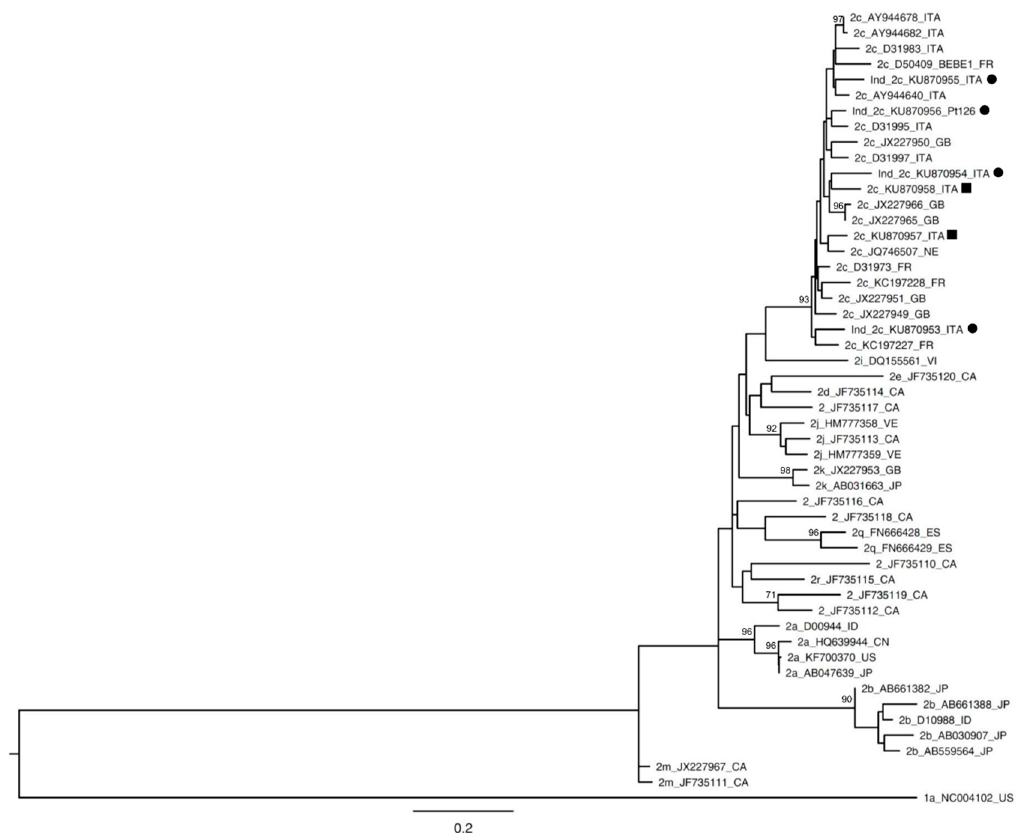
Figure 1. NS5B phylogenetic tree of genotype 2c samples. Bootstrap analysis with 500 replicates is performed to assess the significance of the nodes; values greater than 70% are considered significant and reported in the figure. A genotype 1a sequence (1a_NC004102_US) is used as the outgroup. Sequences from patients with an indeterminate result by Abbott RealTime HCV Genotype II assay are indicated with a circle ( ● ). Reference sequences (1a_NC004102_US; 2c_D50409_BEBE 1_FR) are available in the Los Alamos National Library HCV sequences database [12] and were previously reported as reference sequences by Smith et al. [1]. Sequences indicated with squares ( ■ ) represent the 2c sequences correctly genotyped as genotype 2 by Abbott assay. The bar represents substitution per nucleotide position. CA, Canada; CN, China; DK, Denmark; ES, Spain; FR, France; GB, Great Britain; ID, Indonesia; ITA, Italy; JP, Japan; NE, Nederland; US, United States; VE, Venezuela; VI, Vietnam.